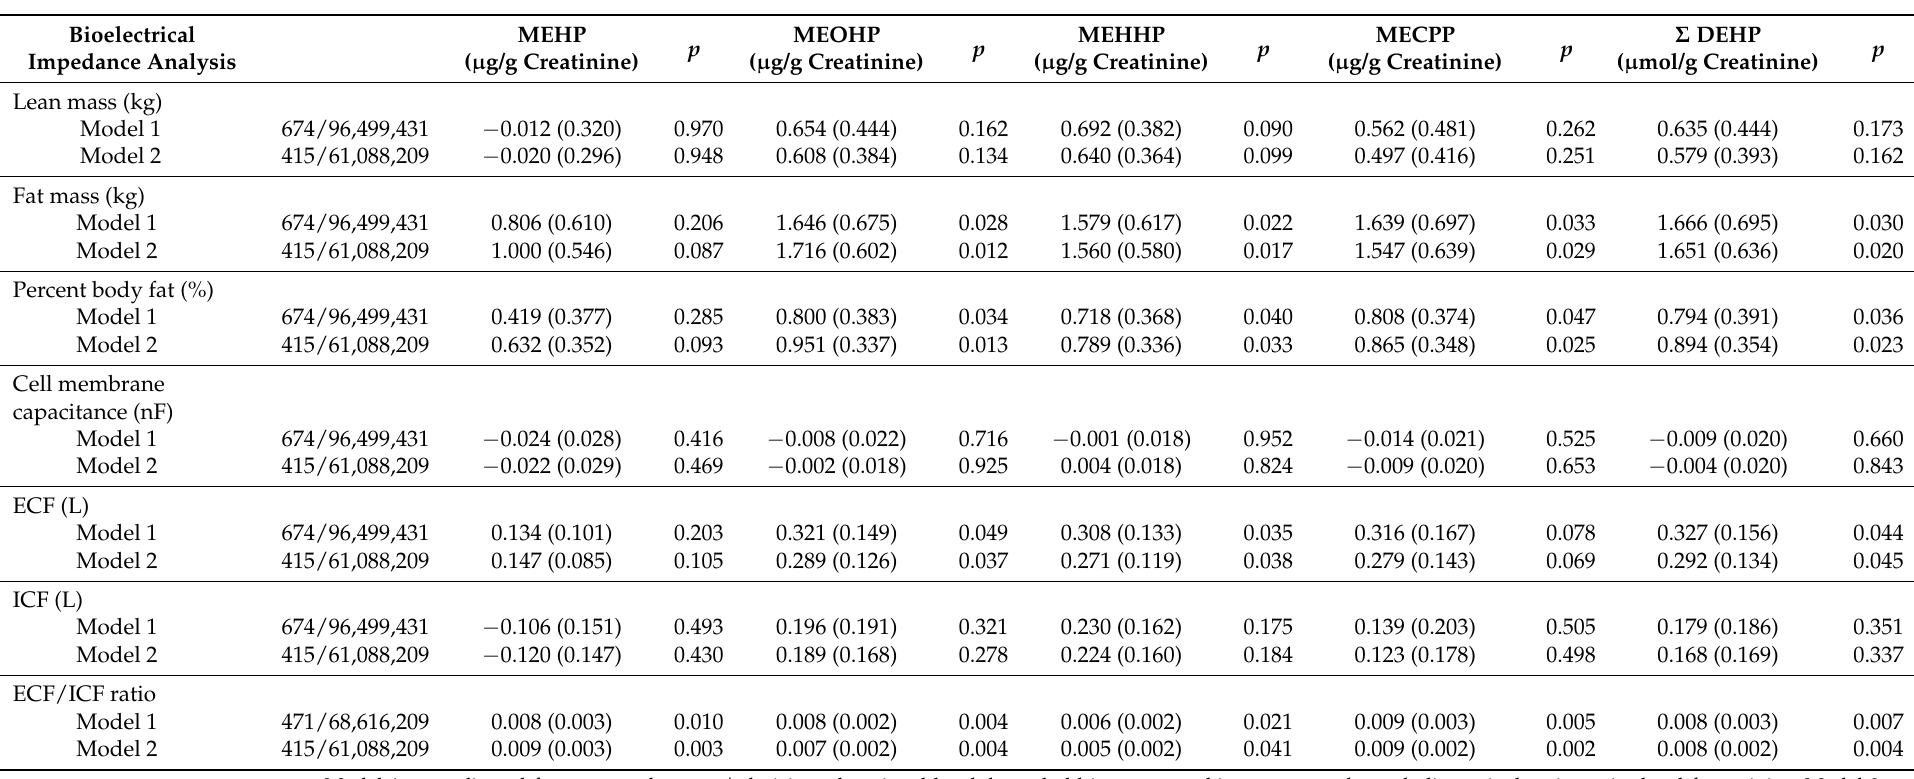
Table 4. Linear regression coefficients (S.E.) of bioelectrical impedance analysis parameters with a one-unit increase in ln-DEHP metabolite concentrations in adults, with results weighted for the sampling